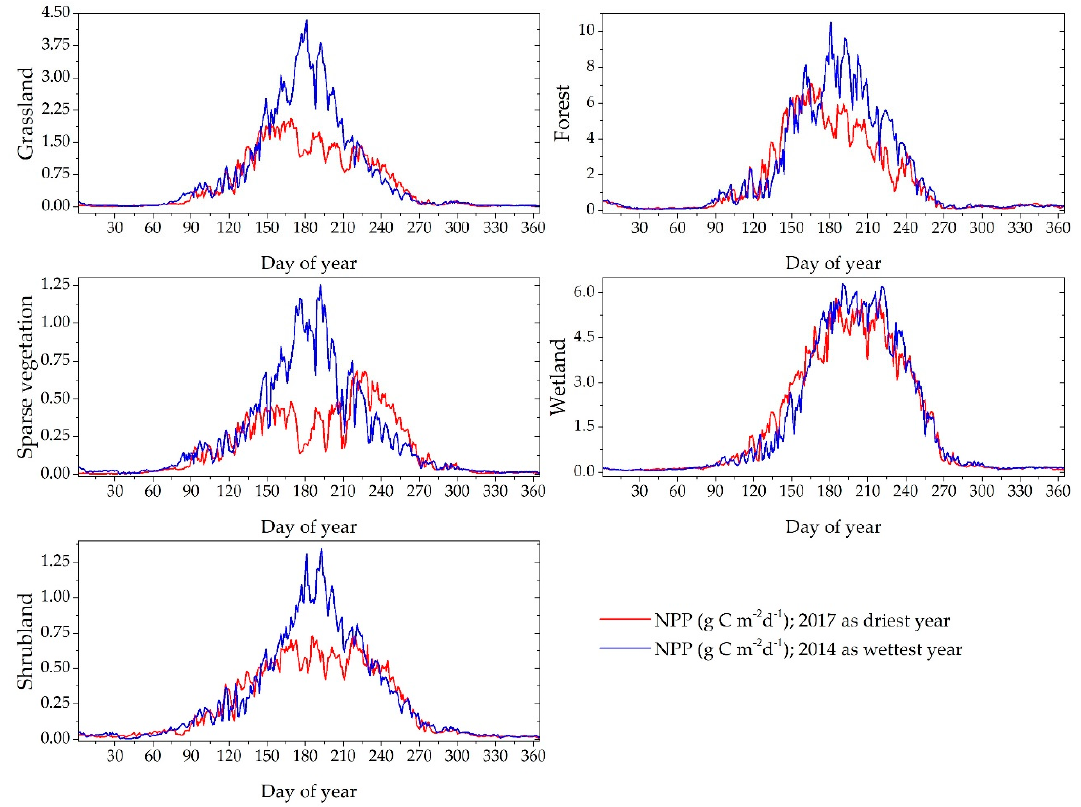
Figure 7. Daily variation of total NPP per unit area over five vegetation types for the years 2014 and 2017.